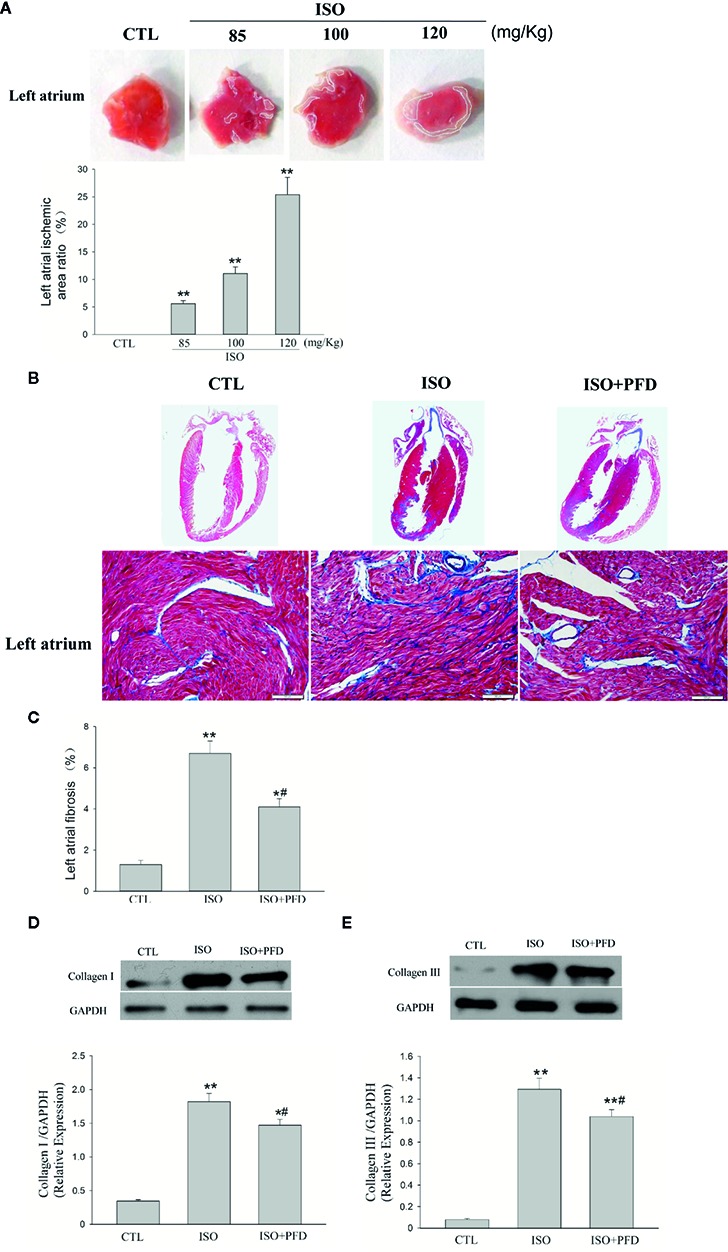
Isoproterenol (ISO) causes left atrial ischemia and fibrosis in rats. (A) Representative images of left atrium by 2, 3, 5-triphenylteyltetrazolium chloride (TTC) staining. Red-colored regions in the TTC stained sections indicate nonischemic areas; pale-colored regions indicate ischemic portions of the heart. Quantification of ischemic area/total area in the left atrium (n = 5 rats/group). (B) Representative images for myocardial fibrosis of the whole heart (Masson’s trichrome staining, which stains fibrosis blue and viable muscle red; scale bar: 100 µm). (C) Quantitation of left atrial fibrosis; ISO increased fibrosis-positive areas in the left atrium. (D) Western blot analysis of collagen I protein expression. ISO increased the protein levels of collagen I in the left atrium (n=5 rats/group). (E) Western blot analysis of collagen I protein amounts. ISO increased the protein levels of collagen III in the left atrium (n=5 rats/group). *P < 0.05, **P < 0.01 versus control (CTL) group; #
P < 0.05 versus ISO group.